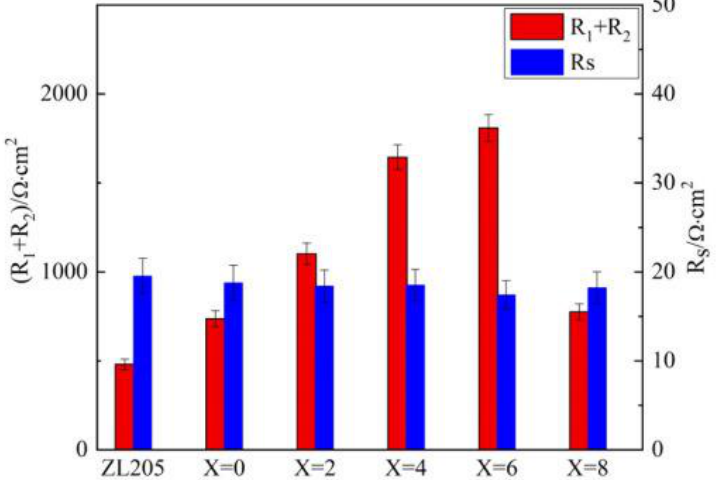
Figure 10. Comparison of the (R 1 + R 2 ) and Rs values in the equivalent circuit of the alloy in the as-cast state.